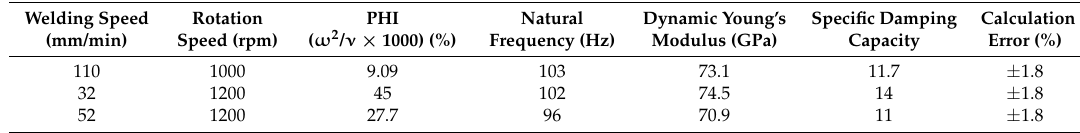
Table 4. The dynamic properties of the defect-free